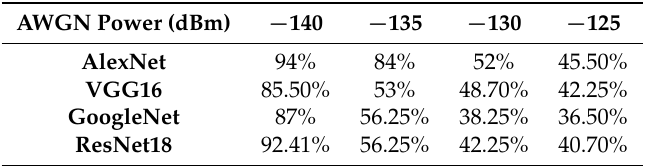
Table 3. The prediction result for AMC1.